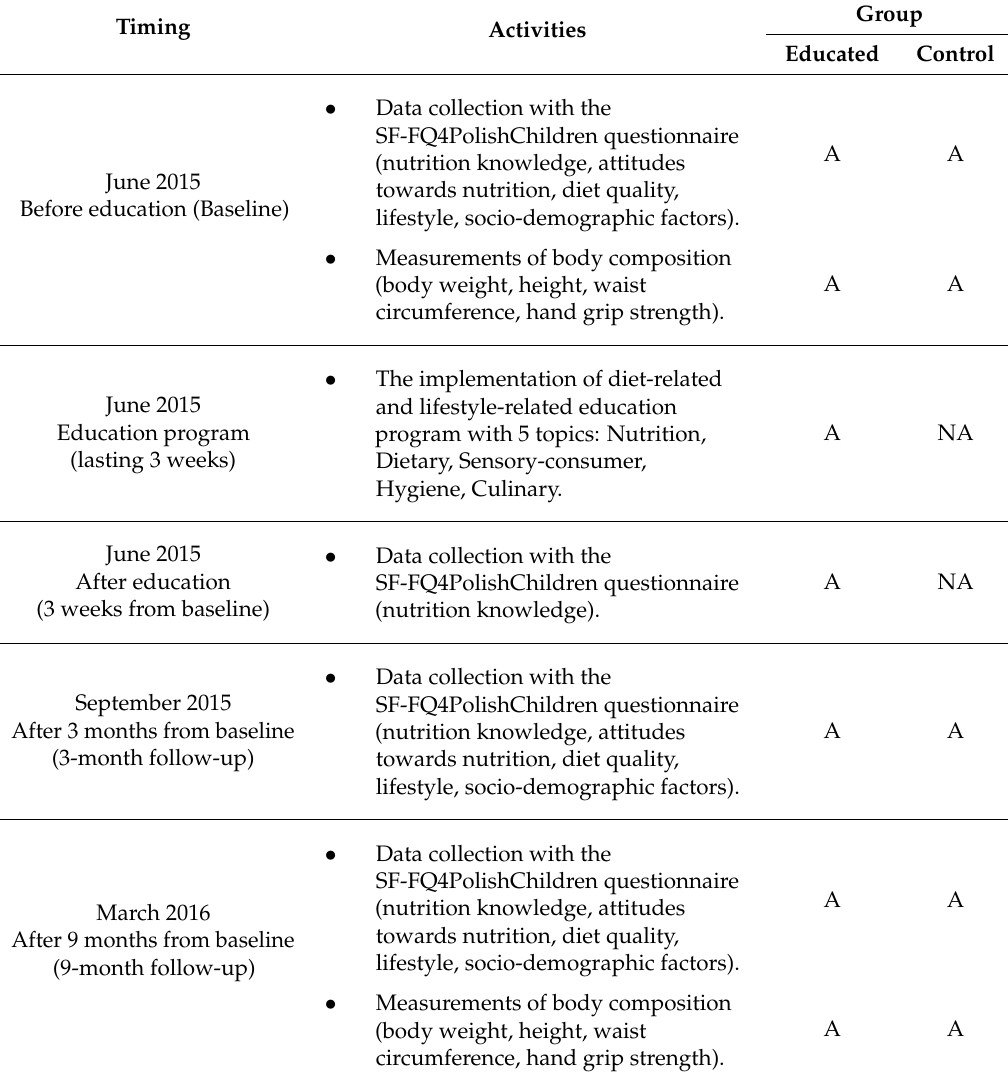
Table 2. The overall content of the education-based intervention